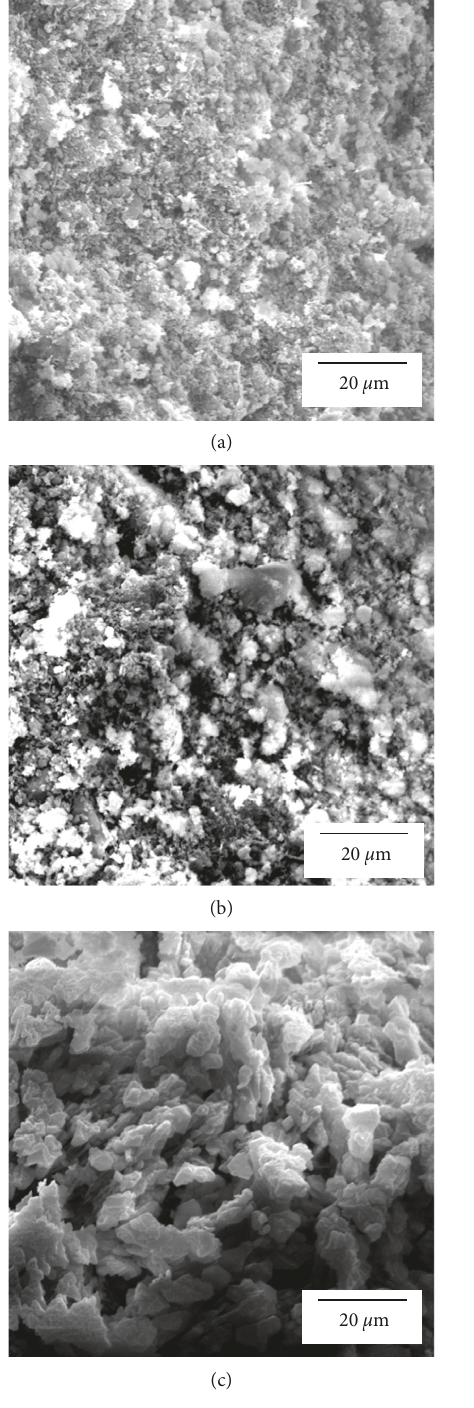
Figure 5: SEM diagram of three kinds of red mud: (a) Bayer red mud from wetting process, (b) Bayer red mud from drying process, and (c) sintering red mud.